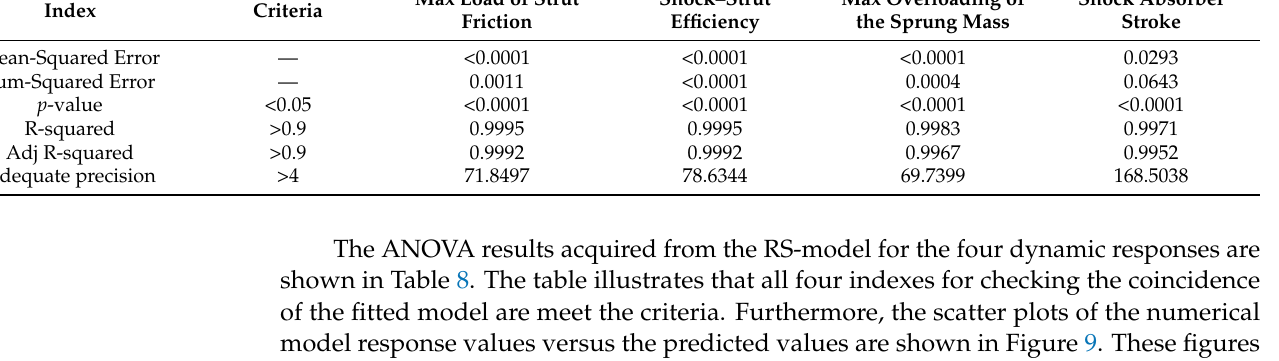
Table 8. The ANOVA results of RS model for the four response values.